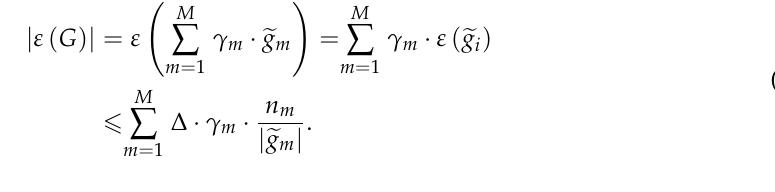
Algorithm 1: Homo Approx. GBDT